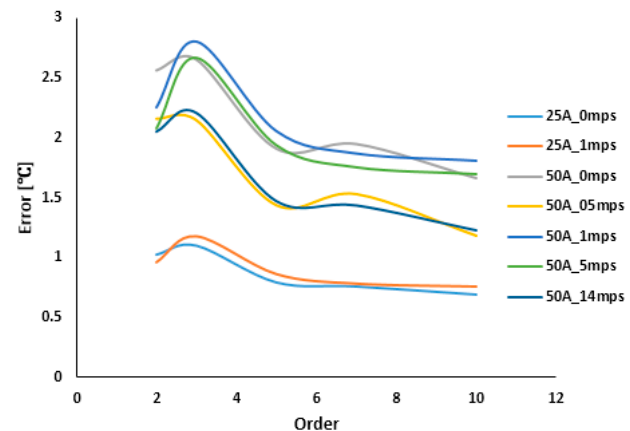
Figure 9. Maximum error vs. model order for VCE method with calibration curve from maximum temperature in cooldown phase.